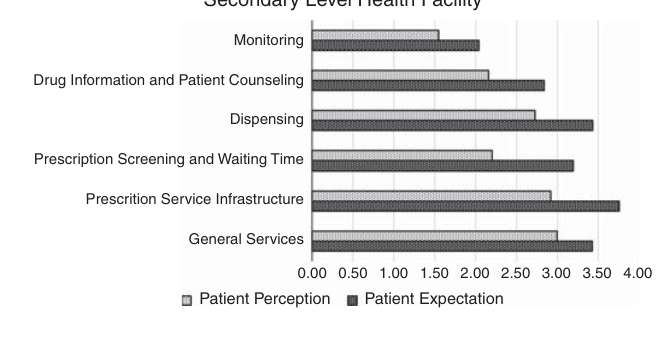
Figure 2. Patient expectation